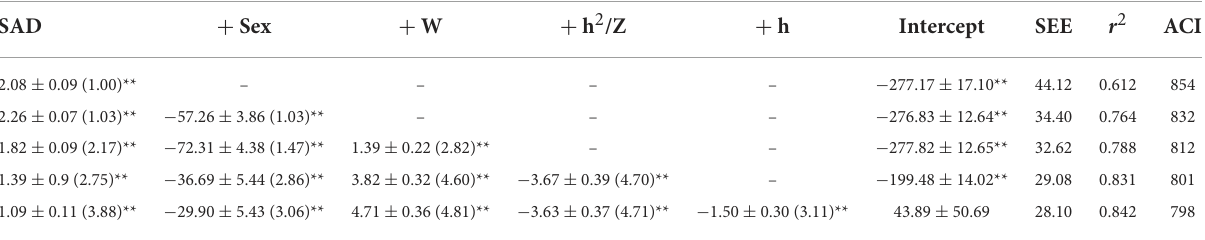
TABLE 2 Multiple regression analysis of sagittal abdominal diameter (SAD) measured with bioelectrical impedance measures as predictor variable and SFA CT as response variable (Modeling group). Cumulative dependent variable used in model ( n = 346)